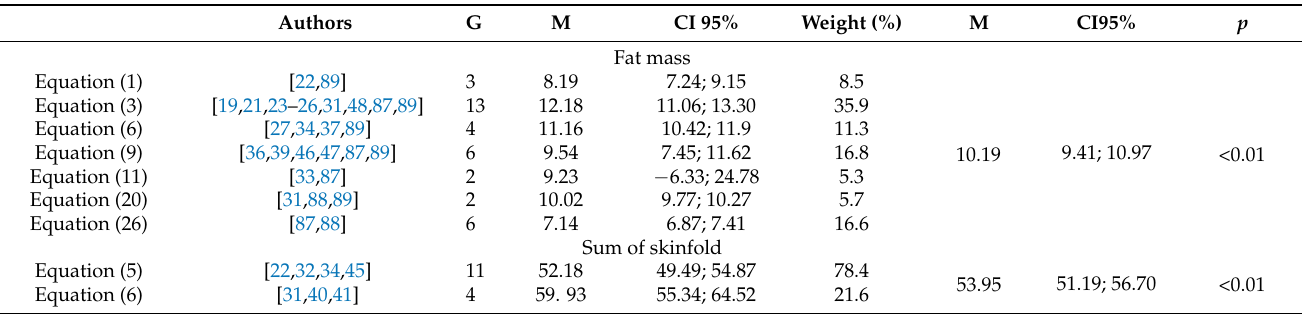
Fat mass: Equation (1) = Carter, 1982; Equation (3) = Durnin and Womersley, 1974; Equation (6) = Faulkner, 1968; Equation (9) = Jackson and Pollock 7 folds, 1978; Equation (11) = Jackson and Pollock 3 folds, 1978; Equation (20) = Reilly, 2009; Equation (26) = Yuhasz, 1974. Sum of skinfolds: Equation (5) = Σ 6 skinfolds (triceps, subscapular, supraspinale, abdominal, mid-thigh, and calf); Equation (6) = Σ 8 folds (biceps, triceps, subscapular, iliac crest, supraspinale, abdominal, mid-thigh, and calf). G = groups; M =